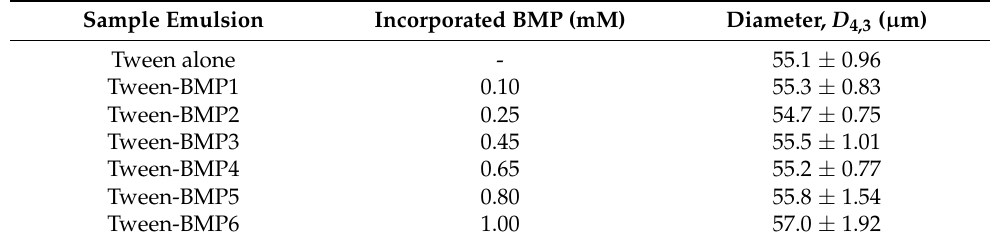
Table 1. The average size of droplets in O/W batches of emulsions ( n = 3) formed from 1 mM Tween 80 solutions in the absence and presence of betamethasone phosphate (BMP) and fabricated at 25 ◦ C in buffered media at pH